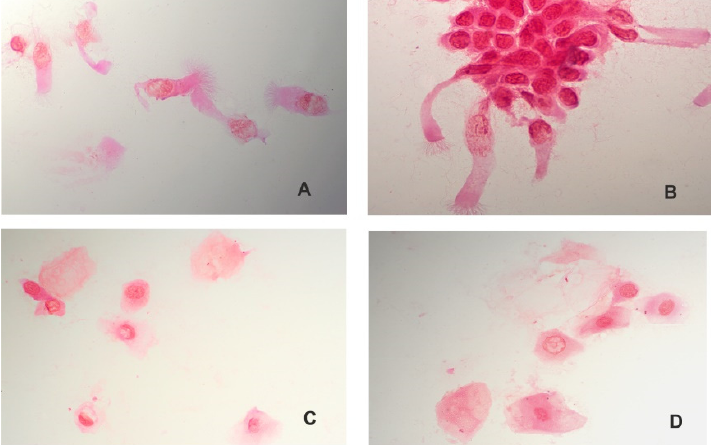
Figure 1. Swabs collected correctly from nasopharynx—visible ciliary cells ( A , B ). Swabs collected incorrectly—epidermal cells from the nasal vestibule are visible ( C , D ). Magnification 600x.